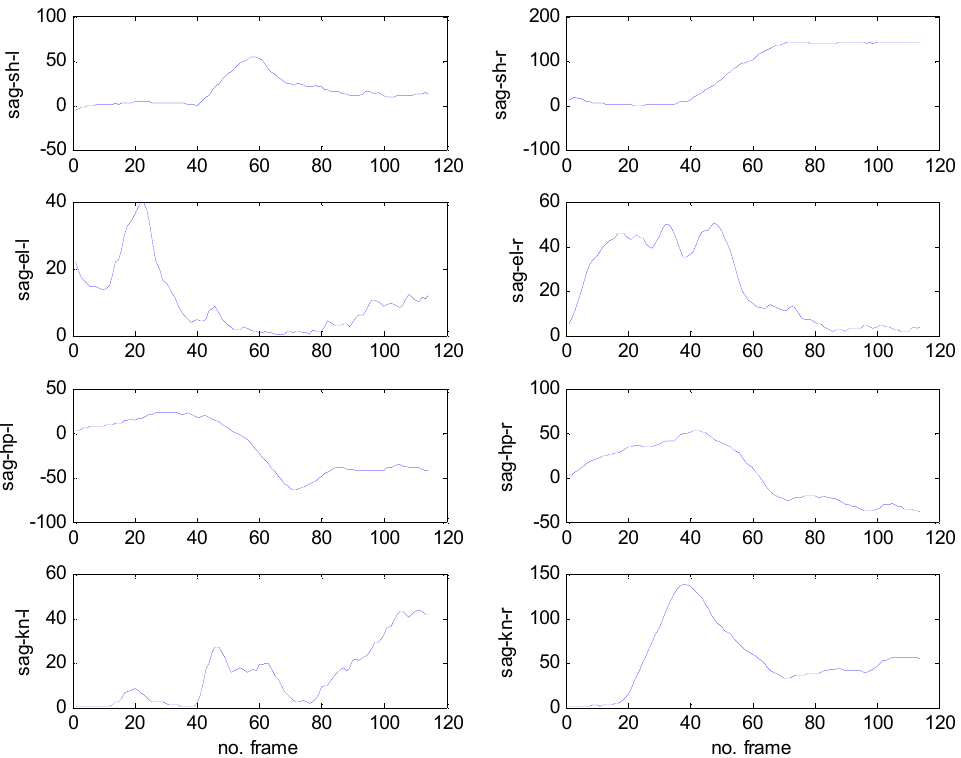
Figure 16. Angular trajectories (in degrees) of the shoulder, elbow, hip, and knee joints in the sagittal